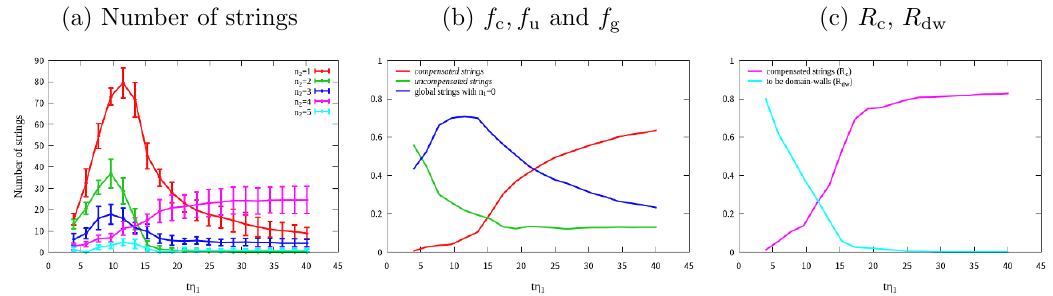
Figure 5. From left to right : the time evolution of the numbers of the strings with various n 2 in the computational domain; the number fractions of the compensated strings ( f c ), the uncompensated strings ( f u ), and the global strings ( f g ); and two kinds of number fractions ( R c ; R dw ) de(cid:12)ned in eqs. (3.6) and (3.7). The horizontal axis is the conformal time normalized by (cid:17) (cid:0) 1